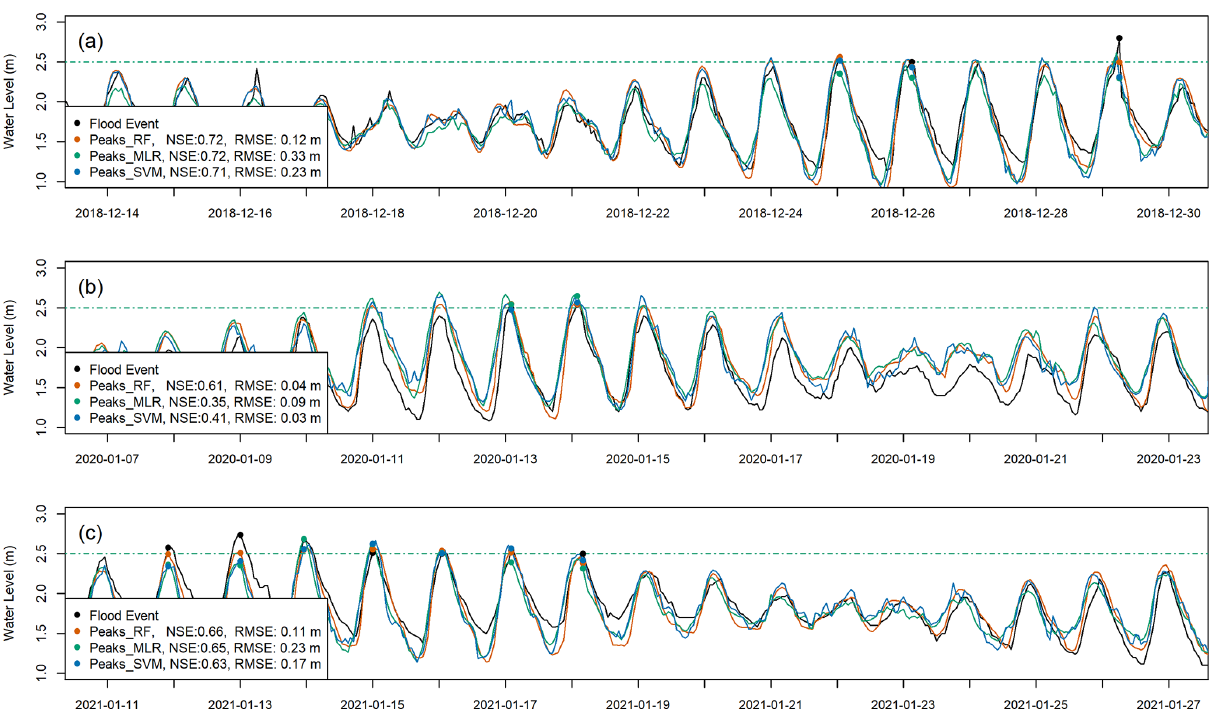
Figure 11. Comparison of predicted hourly water levels models and measured hourly water levels for the implementation phase on: (a)